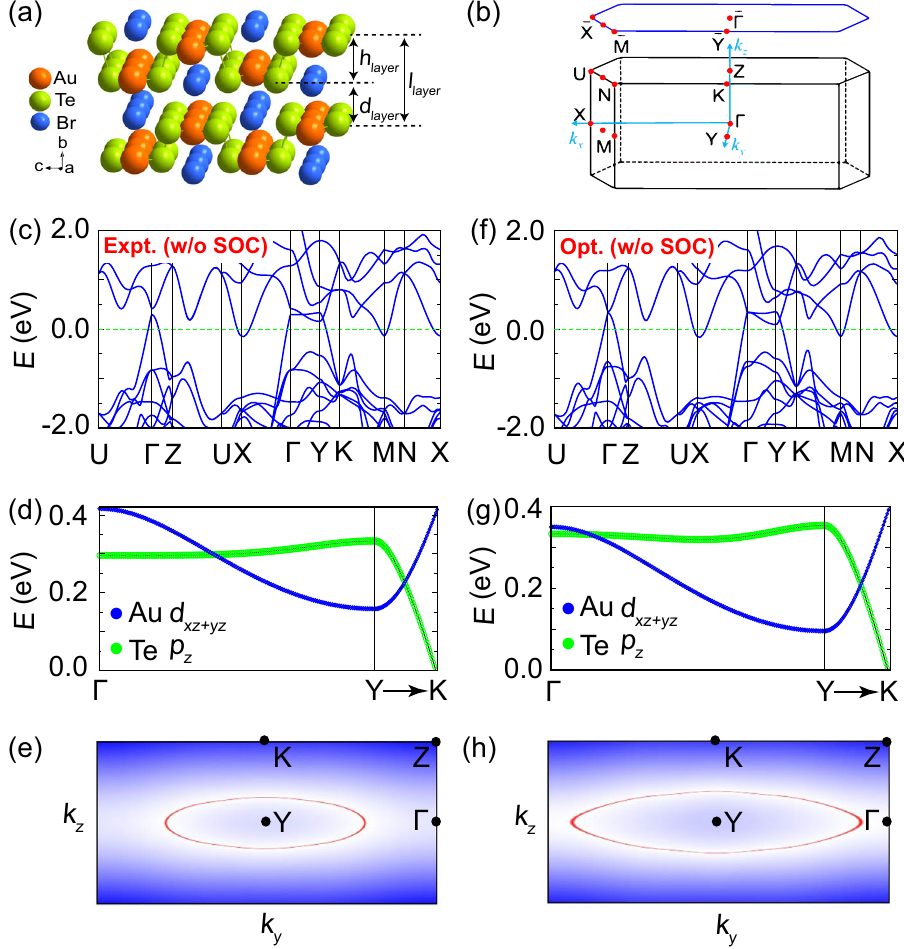
Fig. 1 Band structure calculations for AuTe 2 Br without spin-orbit coupling (SOC). a Crystal structure of AuTe 2 Br with the Cmc 2 1 space group. h layer , d layer and l layer ( l layer = d layer + h layer ) represent the height of an Au – Te layer (i.e., the vertical distance along b between the top and bottom Te atoms in the same Au – Te layer), the vertical distance between the top Te atom in one Au – Te layer and the bottom Te atom in the Au-Te layer above the previous one, and the vertical distance between two adjacent AuTe 2 Br layers, respectively. b The 3D bulk Brillouin zone (BZ). c – e are the calculated band structure, orbital-projected band structures along the Γ -Y-K directions, and the energy difference map between the Au d xz + yz and Te p z bands in the Γ YKZ plane of the BZ for AuTe 2 Br with experimental (Expt.) structural parameters, respectively. f – h are those results with fully optimized (Opt.) structural parameters. The contour of the nodal ring is shown by the red line in ( e ) and ( h ). The background color represents the magnitude of the gap between the Au d xz + yz and Te p z bands. With the gap increasing, the color changes from white to blue. Red ellipse highlights the zero